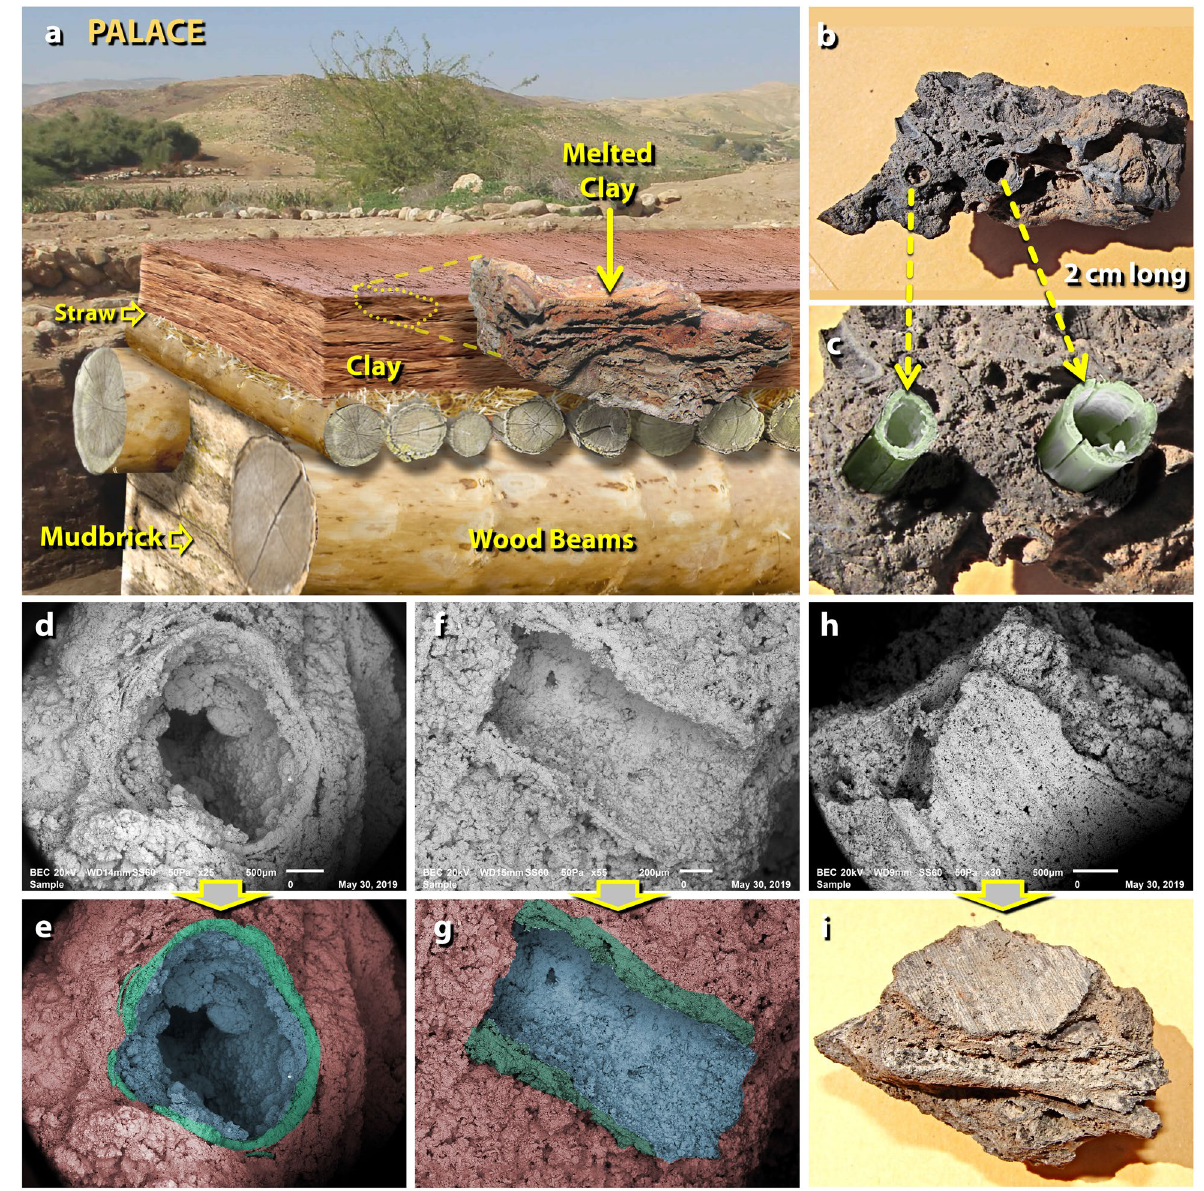
Figure 13. Melted palace roofing clay. ( a ) Artist’s cutaway depiction of typical roof construction at TeH. The construction involved sequentially plastering multiple layers of clay (~ 10 cm or more in total thickness) over a bed of leaves and straw placed over wood beams. “Melted clay” inset at middle right is a photo of melted roofing clay still displaying horizontal layers of clay plaster. ( b ) Fragment of melted roofing clay exhibiting ~ 2-mm-diameter tubular holes left after incineration of straw; ( c ) artist’s depiction, re-creating protruding straw before burning; ( d ) SEM image is the end-view of the hole left by burned straw embedded in roofing clay; ( e ) manually constructed EDS-based phase map of the same image, showing composition as determined by SEM–EDS; red represents melted clay matrix, green represents high-silica glass (60–90 wt.% SiO 2 ) formed from melted silicified straw, and blue represents the silica-rich interior of the hole. ( f ) SEM image is the side-view of the imprint left by burned straw; ( g ) manually constructed EDS-based phase map of the same image, color-coded as in the previous example. ( h ) SEM image of leaf imprint into the clay roofing material, showing the ribbed structure of a leaf; ( i ) photomicrograph of the same